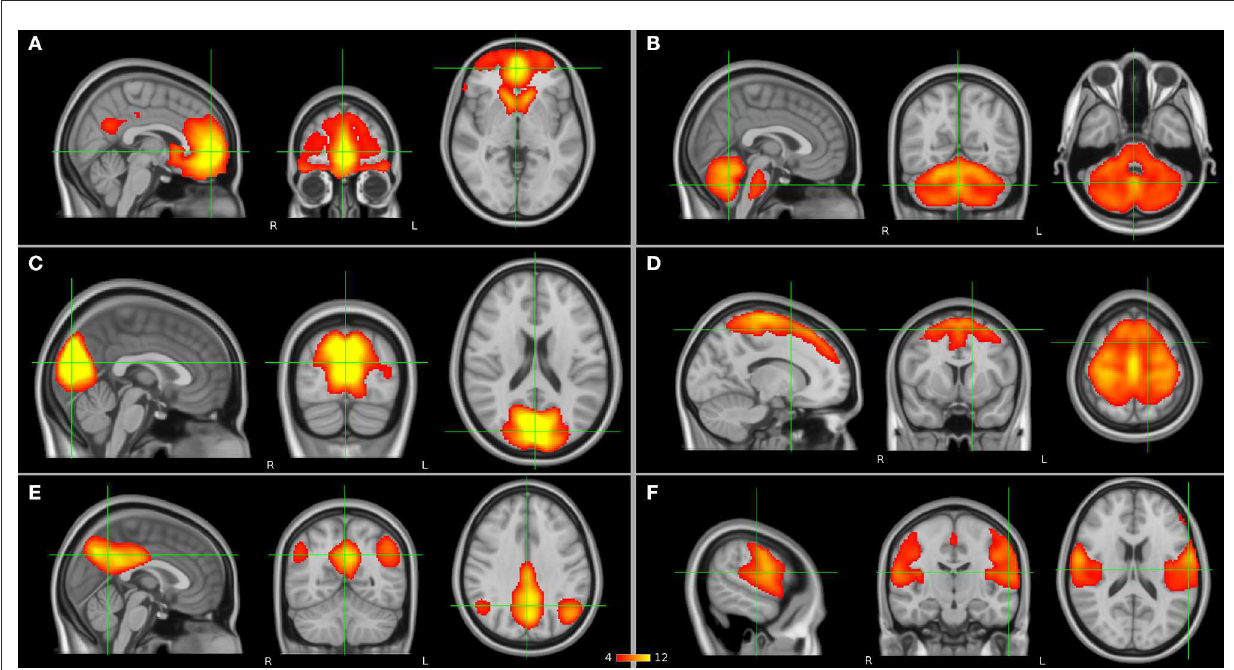
FIGURE1 Resting-state networks (in orange) which have been suggested to have abnormalities in schizophrenia (SCZ) and as presented by independent component analysis (ICA): (A) frontal, (B) cerebellar, (C) visual, (D) somatomotor network (SMN), (E) default mode network (DMN), and (F) auditory